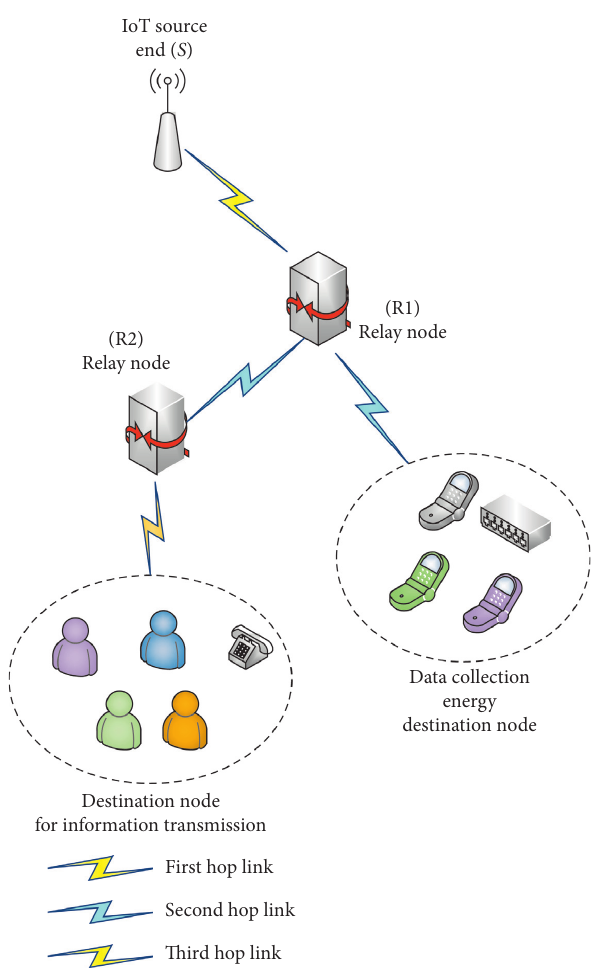
Figure 4: A flowchart of the information transmission model of the intelligent park IoT big data system based on relay cooperation.